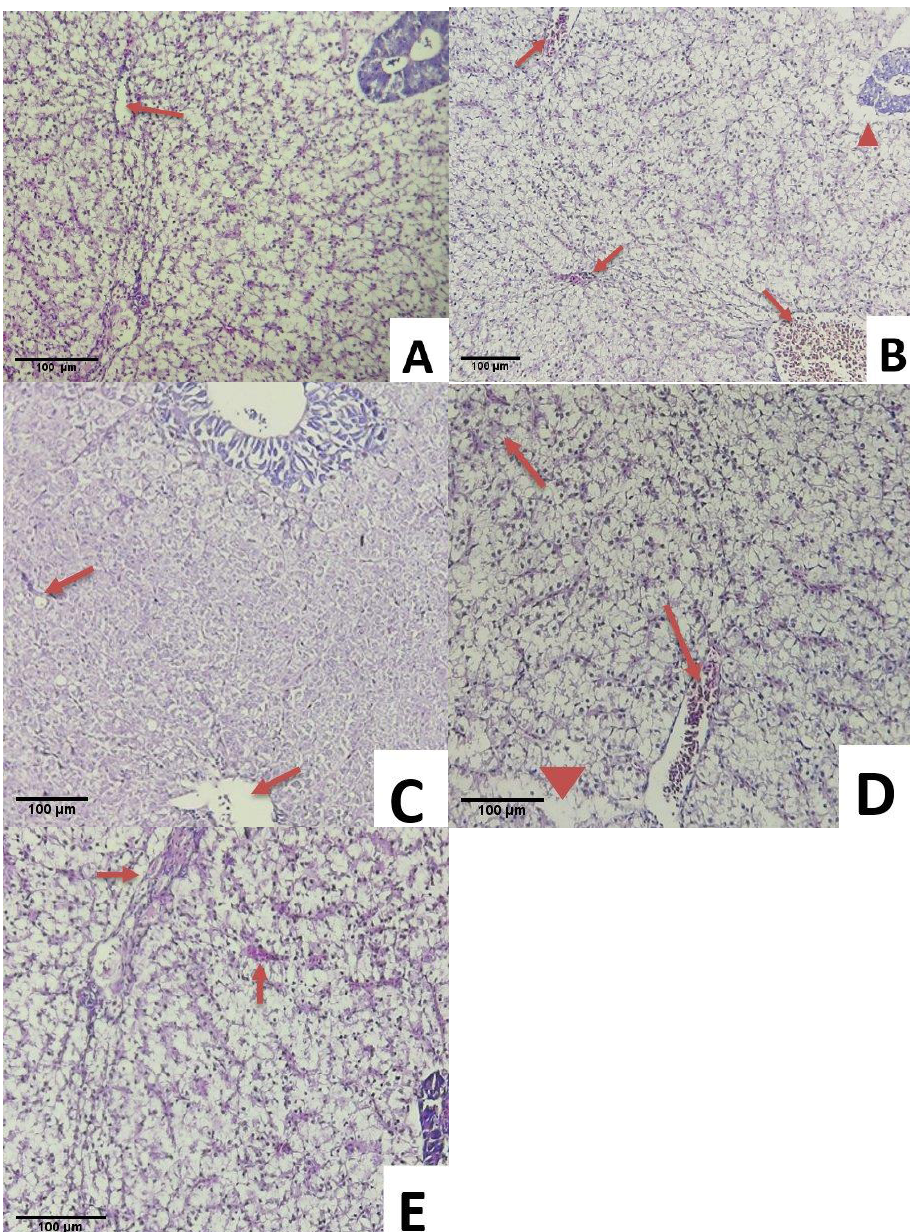
Figure 5. Histological changes in the liver of fish infected with Streptococcus agalactiae : ( A ). Vessel not congested (thin arrow) in CS, ( B ). Severely congested blood vessel (thin arrow) and cell necrosis (short arrow) in S1 ( Streptococcus agalactiae ), ( C ). Severely congested blood vessel (thin arrow) in S2 (Biofloc + Streptococcus agalactiae ), ( D ). Congested blood vessel (thin arrow) and slight cell necrosis (short arrow) in S3 (Biofloc + MG1 + Streptococcus agalactiae ), ( E ). Vessel not congested (thin arrow) in S4 (Biofloc + MP + Streptococcus agalactiae ). (HE staining, 100× magnification). Slight glomerular vacuolation was observed in the kidney samples of CS without S.